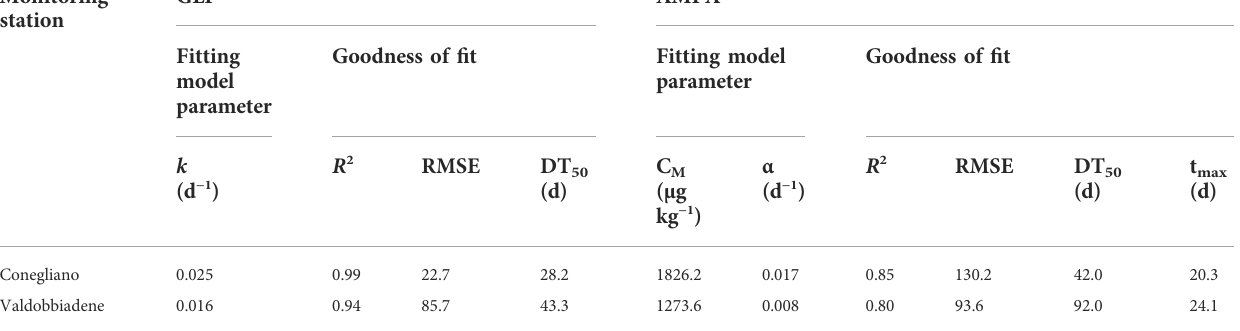
TABLE 5 Rate constants ( k and α ), coef fi cient of determination ( R 2 ), and root mean square error (RMSE) as indicators of the goodness of fi t of glyphosate and AMPA with dissipation times (DT 50 in days) in the topsoil layer (0 – 5 cm) of the four monitoring stations. C M (µg kg − 1 ) is the concentration of the parent molecule that is transformed to AMPA at the initial time and t max (days) is the time at maximum AMPA